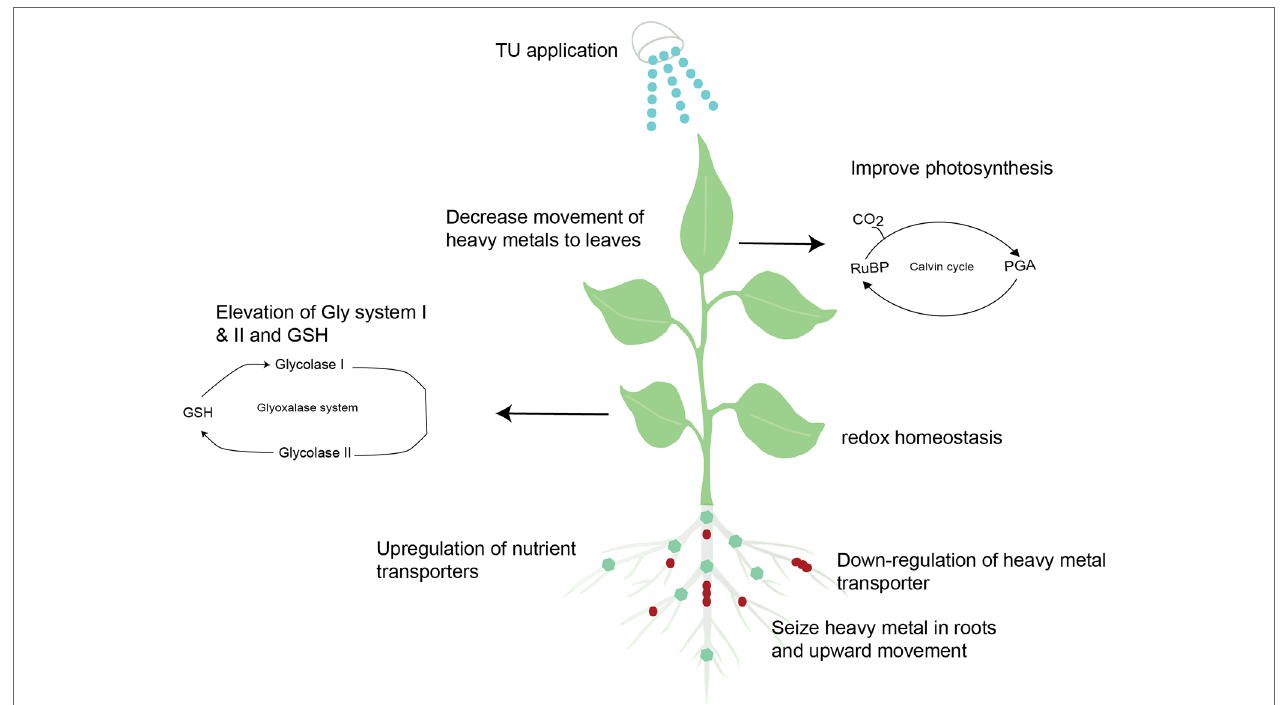
FIGURe 1 | Schematic illustration indicating TU-mediated heavy metal tolerance in